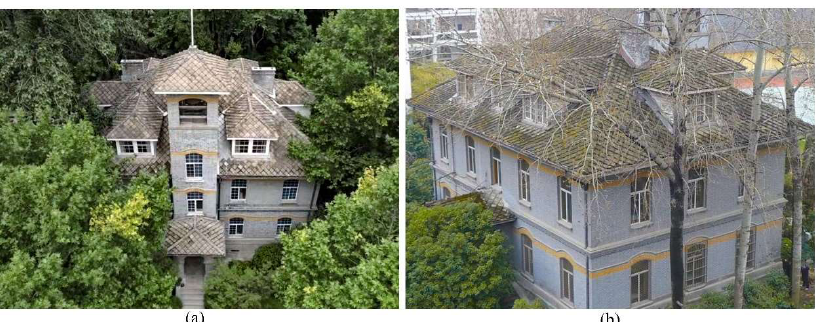
Figure 6. Current photos of the bell tower (source: author). ( a ) Bird’s-eye view of the bell tower from south to north.( b ) Bird’s-eye view of the bell tower from the northwest.